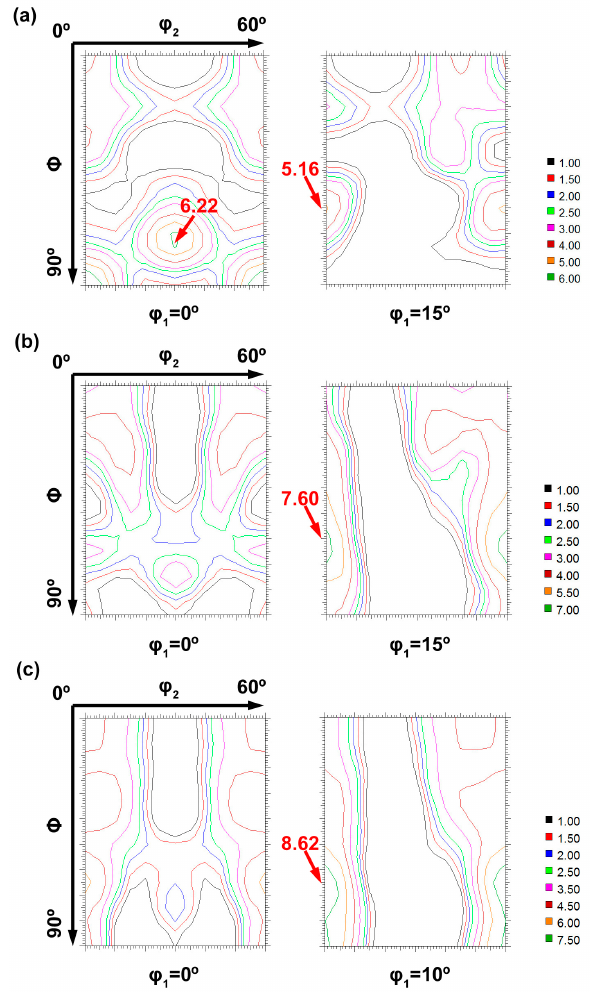
Figure 5. Representation of orientation distribution function (ODF) sections at constant φ 1 corresponding to warm-drawn states: ( a ) as-received state: φ 1 = 0° and φ 1 = 15°; ( b ) 30% warm-drawn state: φ 1 = 0° and φ 1 = 15°; ( c ) 60% warm-drawn state: φ 1 = 0° and φ 1 = 10°.